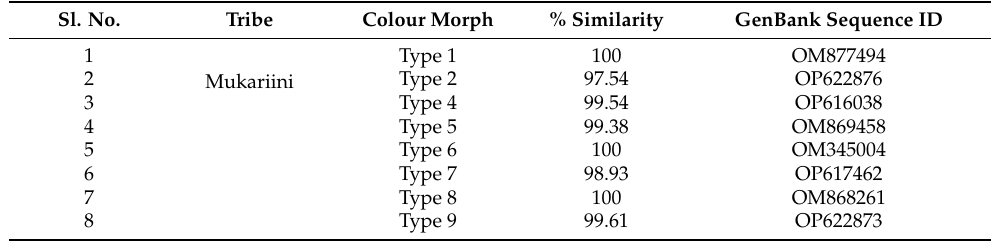
Table 1. Details of the sample data used in the molecular analysis of the M. splendida (male) population. Sl. No.